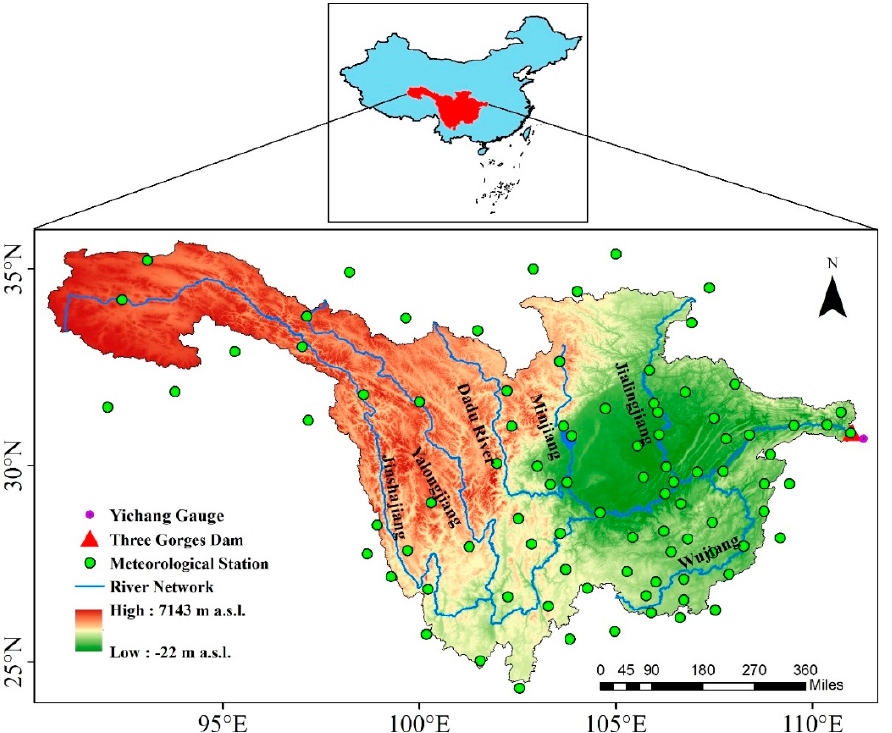
Figure 4. Locations upstream of Three Gorges Hydroelectric Power Station and meteorological stations. m a.s.l., meters above sea level.